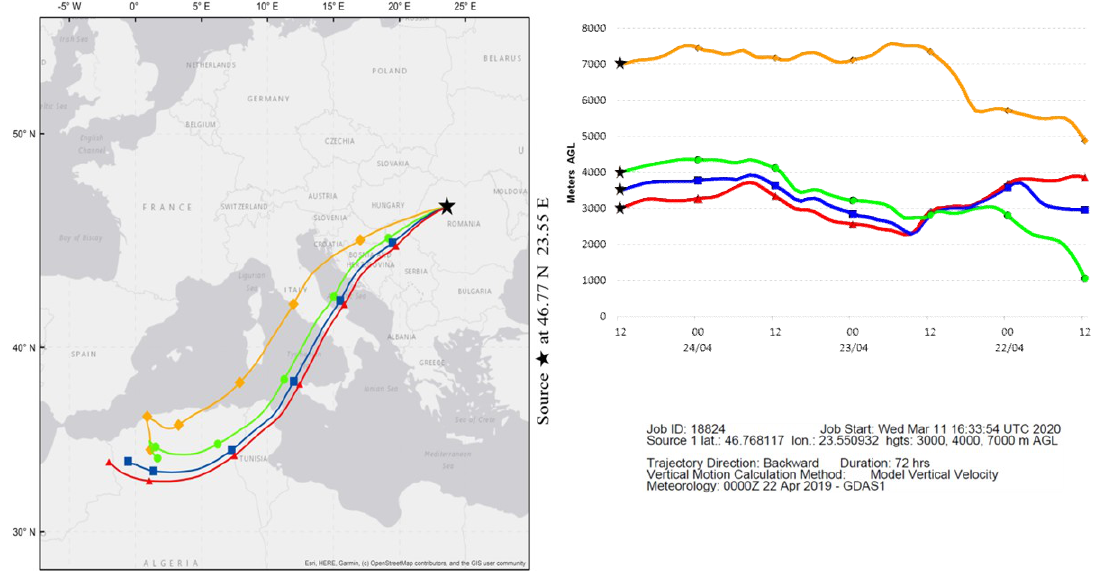
Figure 7. HYSPLIT back‐trajectories obtained for 24.04.2019 at 12:00 UTC.